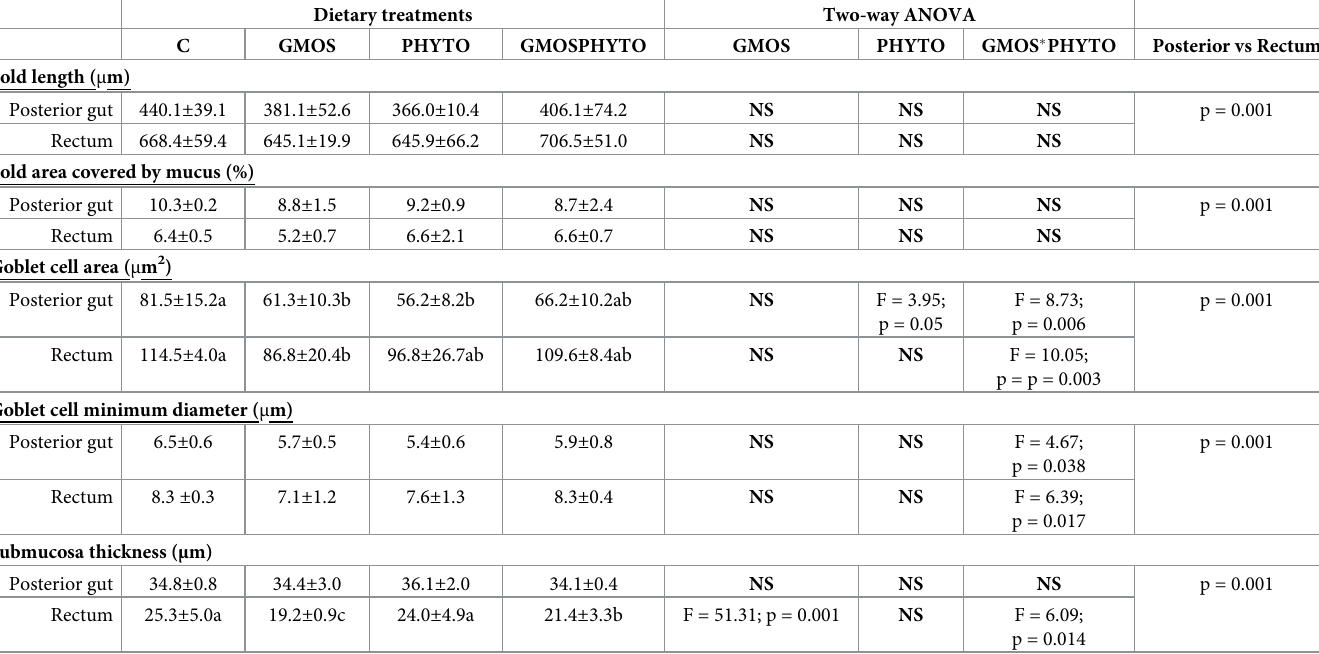
Table 6. Posterior intestine and rectum morphometric parameters for European sea bass ( Dicentrarchus labrax ) juveniles at the end of the feeding trial (63days). Dietary treatments Two-way